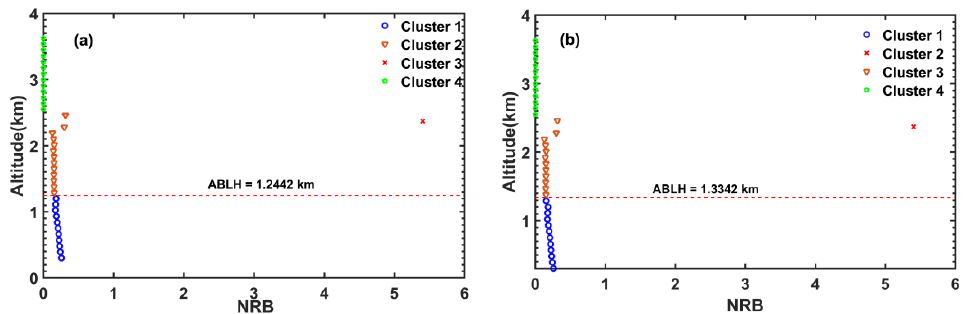
Figure 3. The gradient of NRB processed by interval thresholding technique.